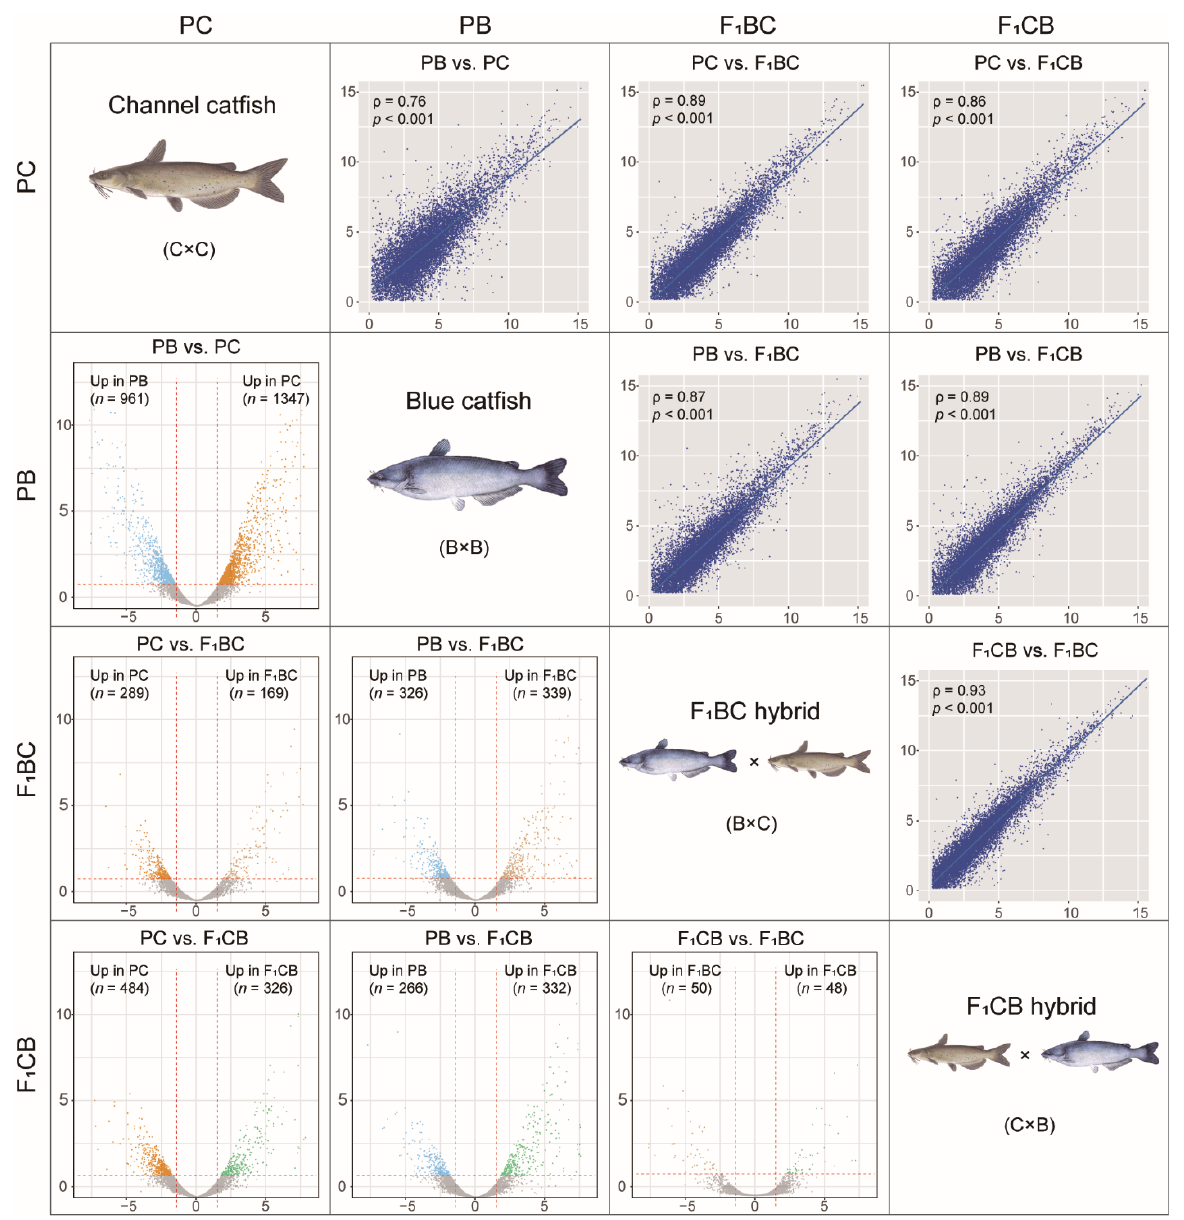
Figure 3. Transcriptome ‐ wide gene expression correlation and differentially expressed genes in the liver among channel catfish (C), Ictalurus punctatus , blue catfish (B), I. furcatus , and their reciprocal F 1 hybrids raised in the tank environment ( diagonal panels ). Bottom ‐ left panels: volcano plots of six pairwise comparisons among the four genetic types from channel catfish parental cross (PC), blue catfish parental cross (PB), blue catfish female × channel catfish male hybrids (F 1 BC), and channel catfish female × blue catfish male hybrids (F 1 CB). Differentially expressed genes (DEGs) are highlighted (FDR < 0.05). The x ‐ axis stands for log 2 fold changes, and the y ‐ axis represents − log 10 ( p ‐ value). The vertical lines indicate |log 2 FoldChange| = 1.5. Upper ‐ right panels: scatterplots of the log 2 (RKPM) values for six pairwise comparisons among the four genetic types. Spearman’s rank correlation coefficient ρ and the corresponding p ‐ values are labeled.